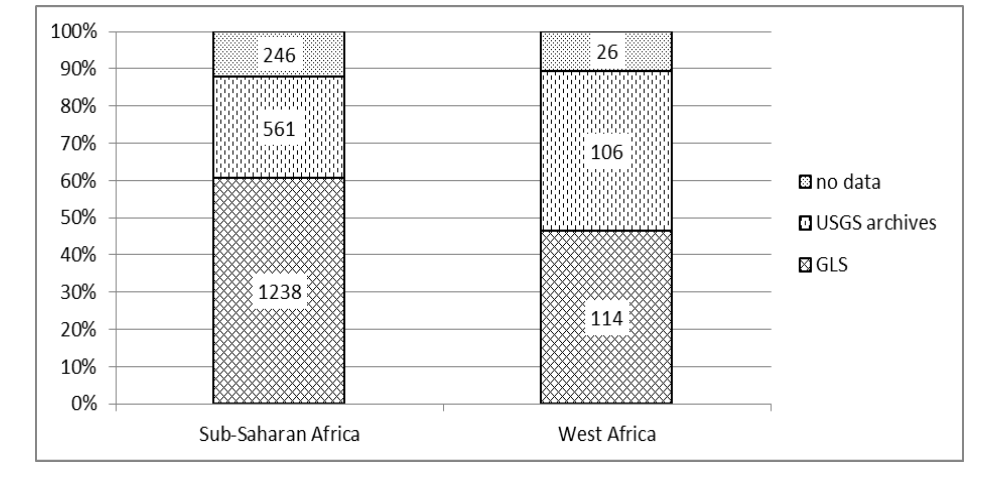
Figure 3. Repartition of Landsat MSS image extracts availability depending on the data source comparing sub-Saharan and West Africa (figures correspond to the number of concerned sample sites).